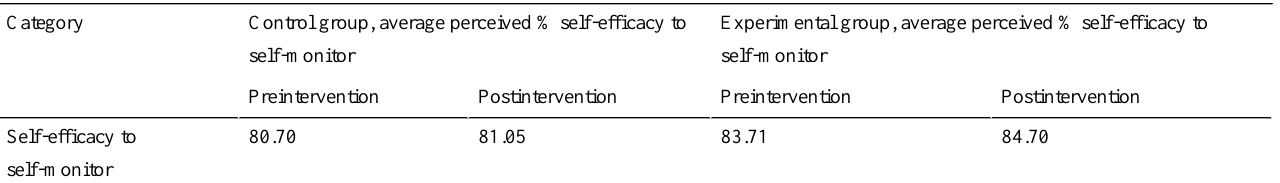
Table 7. Self-efficacy to self-monitor